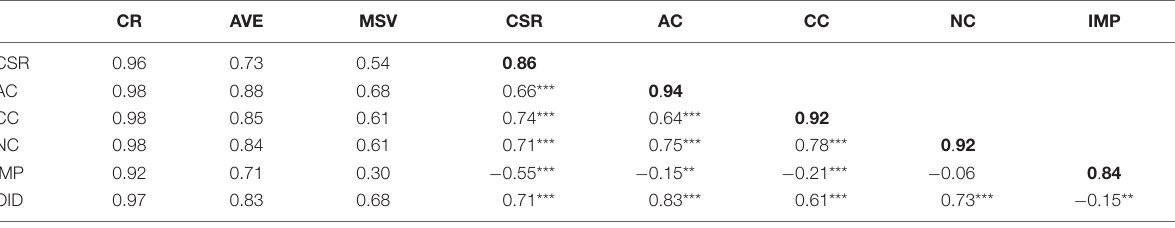
TABLE 2 | The results of convergent and discriminant validity analysis.